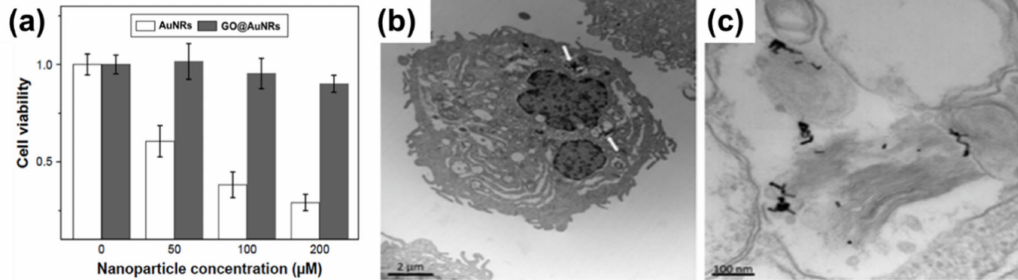
Figure 7. ( a ) Cell viabilities of AuNRs and GO@AuNRs against A549 cells. Reproduced from [37], with permission from Dove Medical Press, 2017. ( b , c ) High-magnification transmission electron microscopy image of internalization of AuNRs–PEG–GO composite in a cells. Adapted from [29], with permission from Wiley,